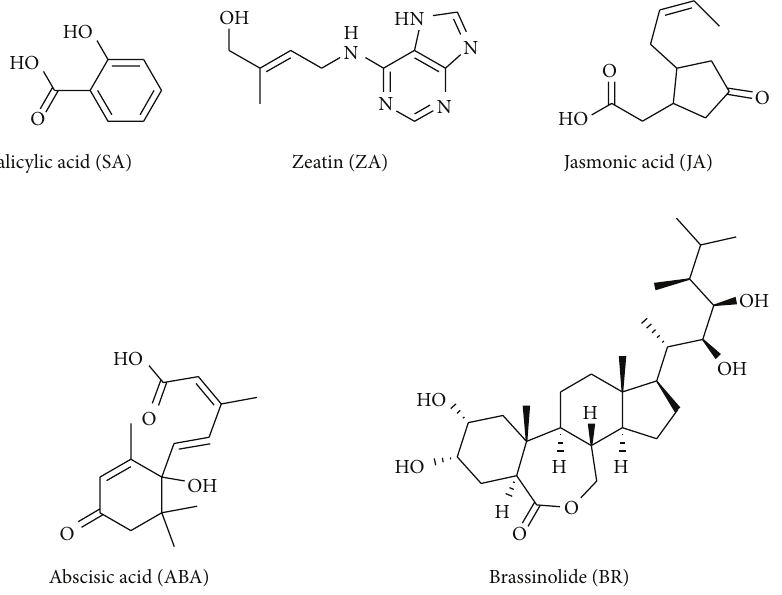
Figure 1: Structures of five plant